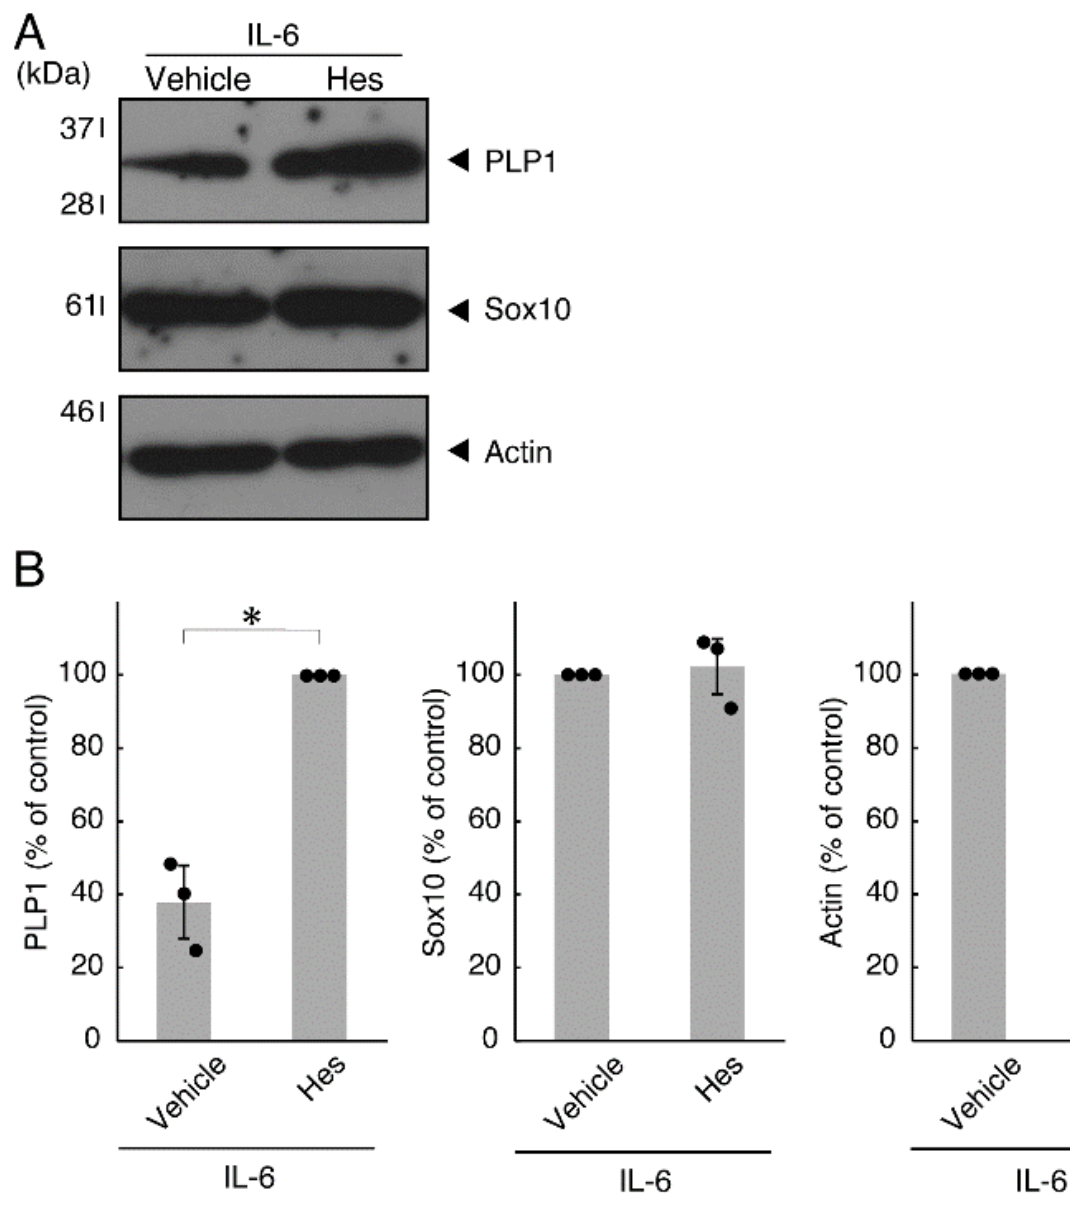
Figure 9. Effects of hesperetin on expression levels of oligodendroglial cell marker proteins in the presence of IL-6. ( A , B ) Cells treated with IL-6 in the presence of hesperetin (Hes) or control vehicles. The PLP1, Sox10, or control actin blot is shown. Immunoreactive band intensities were also compared to be depicted in graphs (*, p < 0.05; n = 3 blots [obtaining one sample each from 3 independent experiments]).